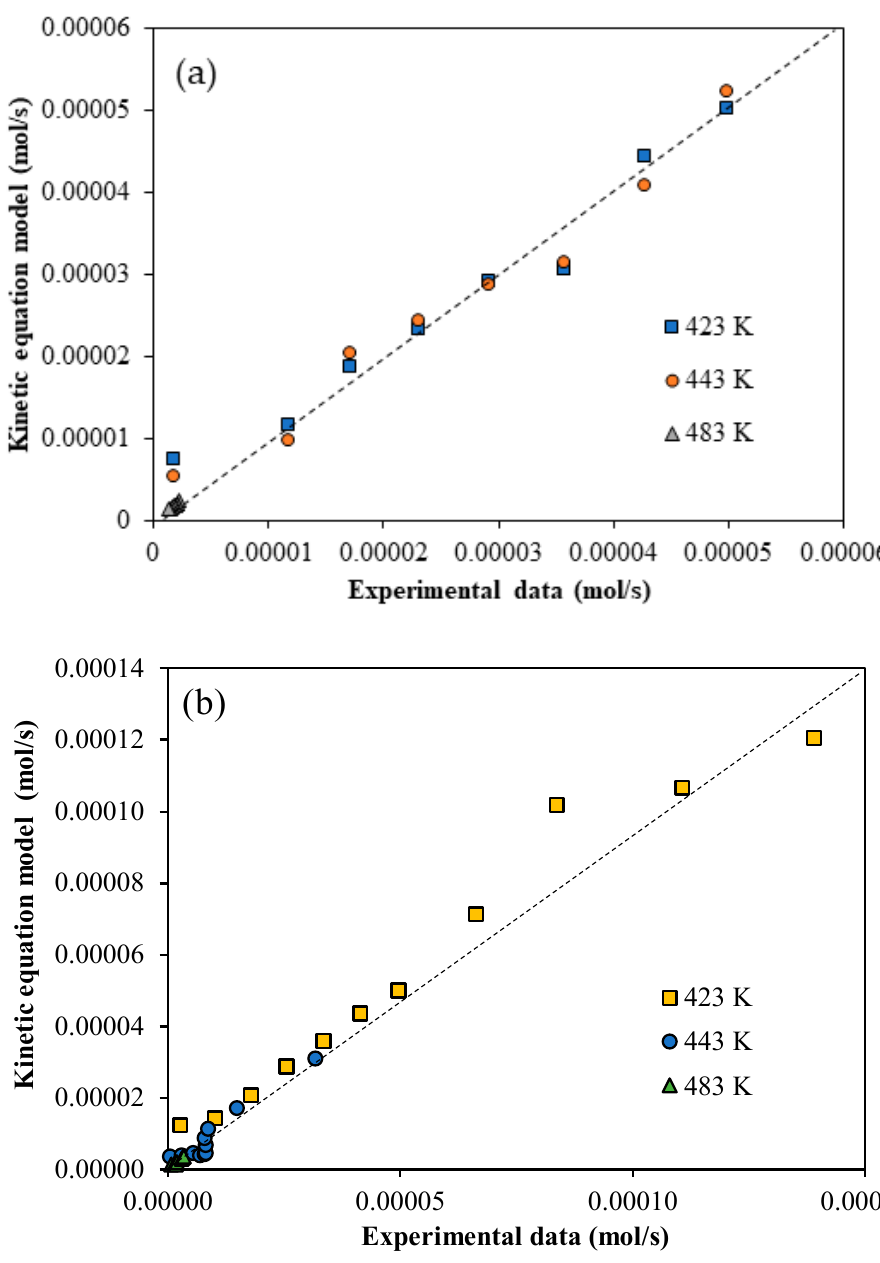
Figure 5. Parity curves of the reaction rate constants obtained from the experimental data and those calculated from the best fit equations for ( a ) the dimerization reaction and ( b ) the trimerization